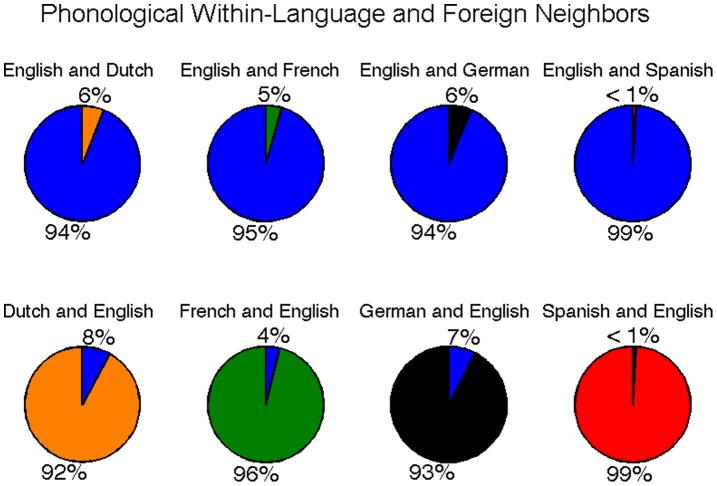
Ratio of within-language and foreign phonological neighbors as part of total neighborhood size for each word.The top row compares the proportion of English within-language neighbors (blue) to foreign neighbors in each other language. The bottom row compares the proportion of within-language neighbors in each language to foreign (i.e., English) neighbors (blue).